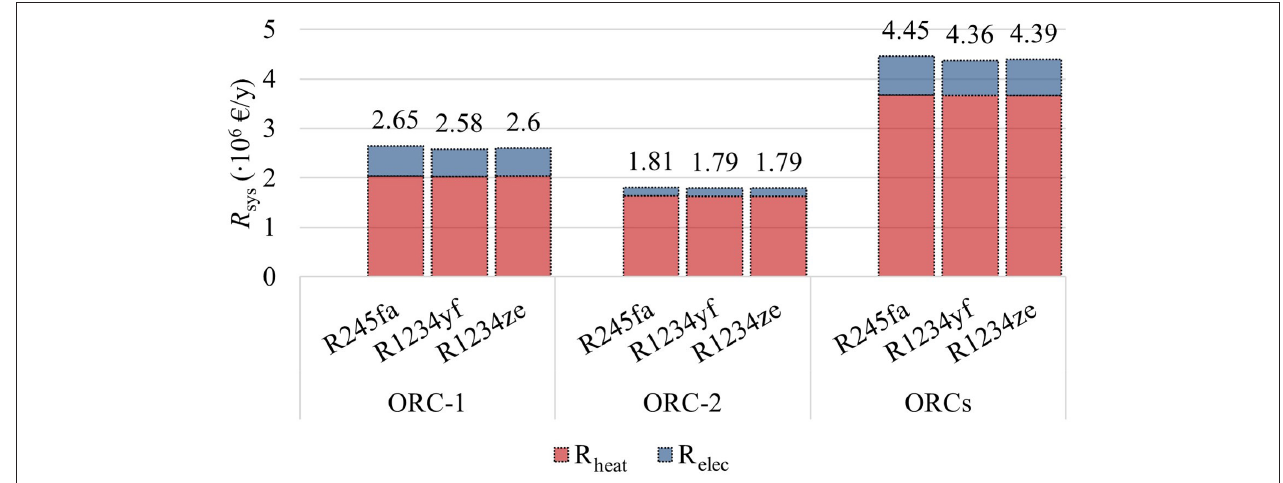
FIGURE 11 | Maximum values of revenue for optimized ORC system.